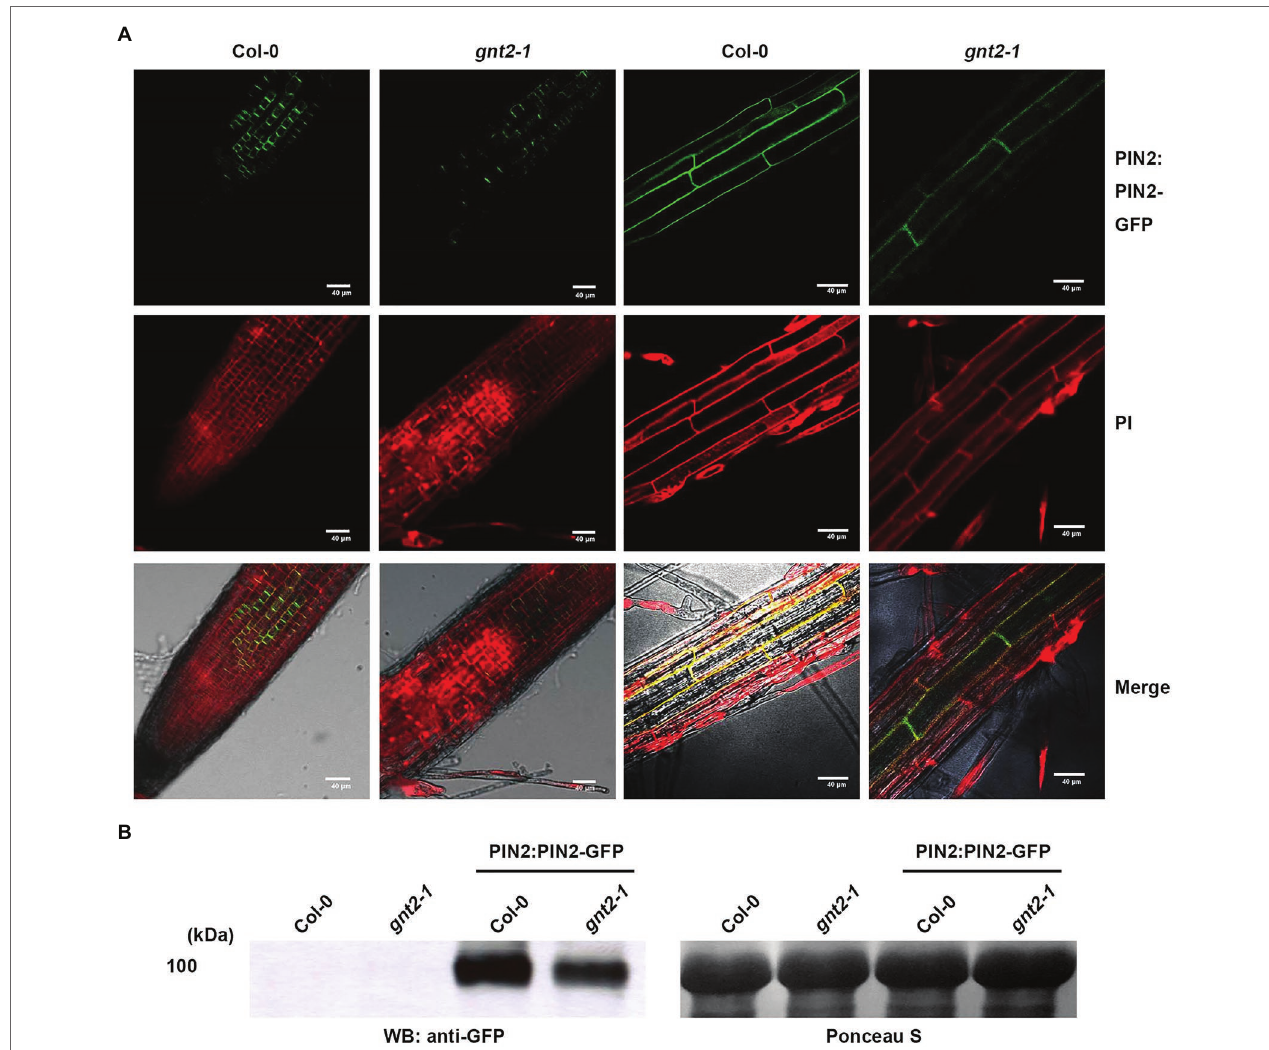
FIGURE 8 | The stability and subcellular localization of PIN2-GFP are changed in gnt2-1 under stress conditions. (A,B) Arabidopsis seedlings grown on tissue culture plates containing MS medium supplemented with 60 mm NaCl for 7 day were used. (A) The expression of PIN2:PIN2-GFP in Col-0 and gnt2-1 background. The PIN2:PIN2–GFP localization in the root apical tissues of Col-0 and gnt2-1 was visualized under a confocal laser scanning microscope (FV1000; Olympus). Scale bar =